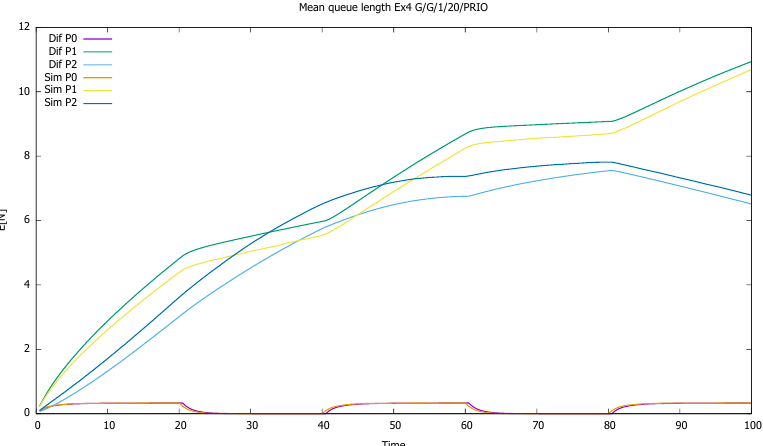
Figure 13. Section 3.4, three priorities: mean queue lengths as a function of time for priority (P0), medium-priority (P1), and low-priority classes.